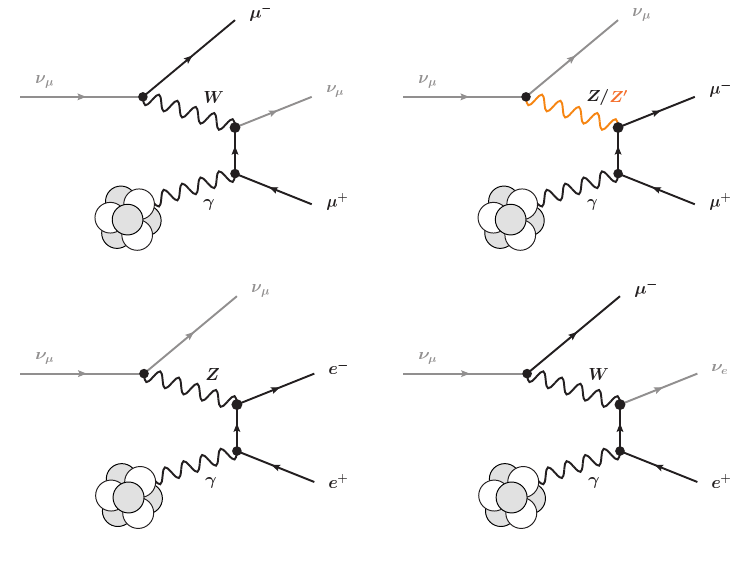
Figure 156. Example diagrams for ν µ -induced trident processes in the SM. A second set of diagrams where the photon couples to the negatively charged leptons is not shown. Analogous diagrams exist for processes induced by different neutrino flavors and by antineutrinos. A diagram illustrating trident interactions mediated by a new Z (cid:48) gauge boson, discussed in the text, is shown on the top